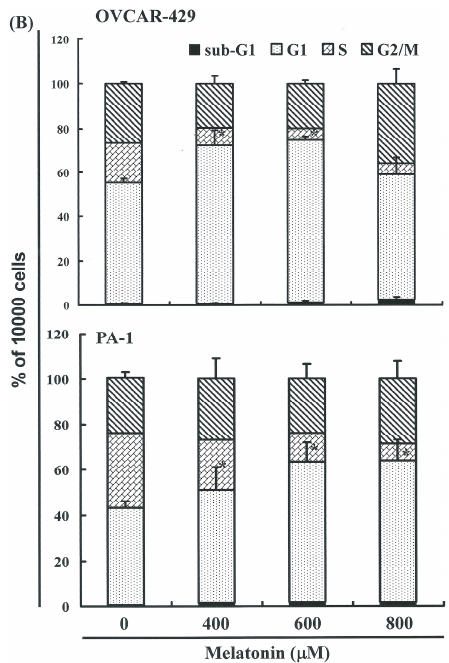
Figure 3. Influence of melatonin on cell cycle progression/distribution in OVCAR-429 and PA-1 cells: ( A ) Cell cycle analysis of ovarian cancer cell lines after being cultured with melatonin for 24 h; ( B ) melatonin induced an increase in G 1 phase cells (%).The * symbol indicates that the difference resulting from treatment with melatonin 0 µM is statistically significant at p <0.05.